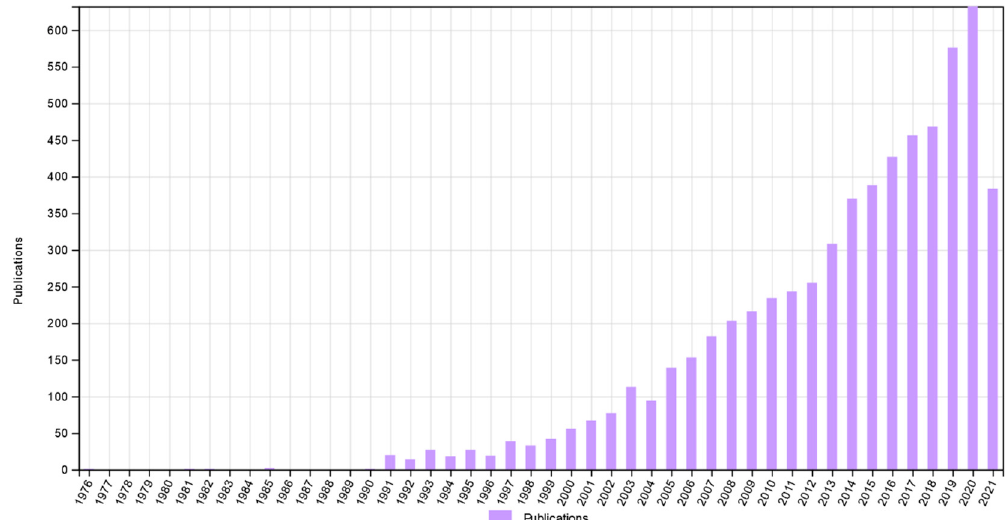
Figure 1. Numbers of publications over time when searching “privileged structure” as topic term (according to Web of Science, date: 27 September 2021).